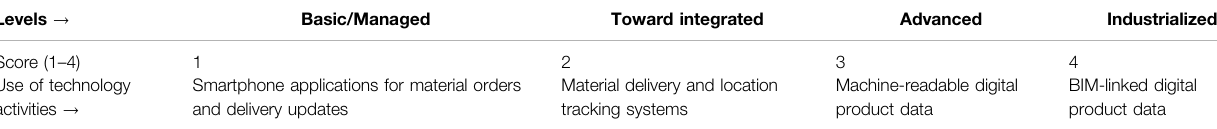
TABLE 8 | Use of technology maturity.